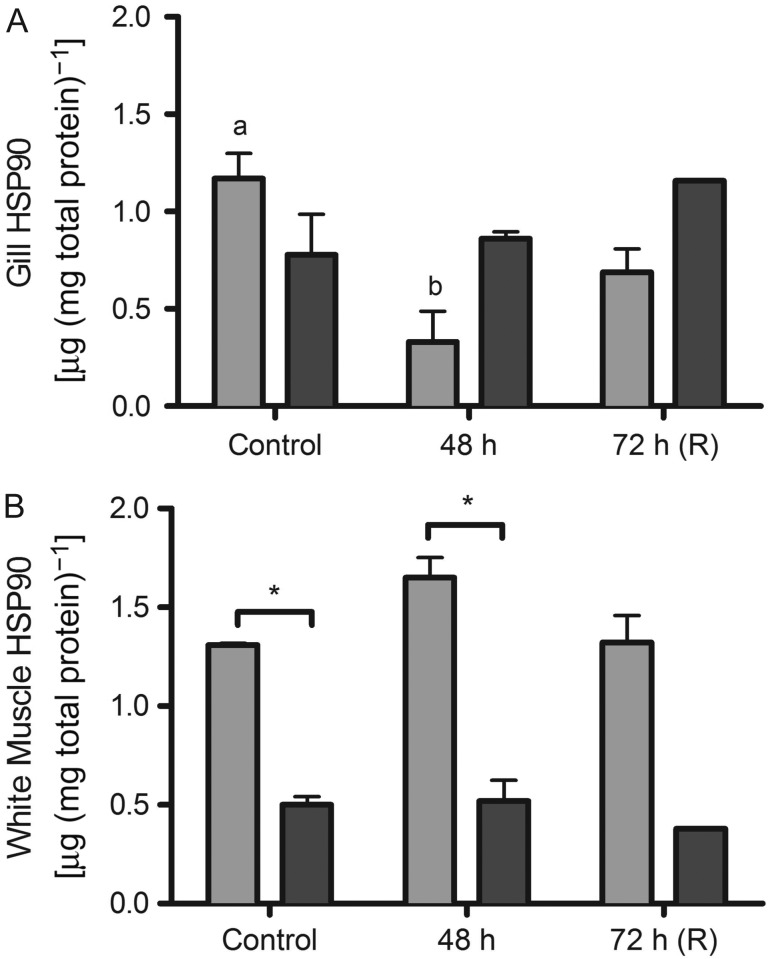
Heat-shock protein 90 (HSP90; in nanograms of HSP90 per microgram of total
protein; mean values ± SEM) in school shark (G.
galeus) and gummy shark (M. antarcticus) gill
(A) and white muscle (B) following exposure to
75% seawater. Different letters indicate statistically significant
differences over time. Asterisk indicates significant difference between
species (P < 0.05; see Materials and
methods for species replication numbers). Recovery (R) data are not included
in the statistical analyses.